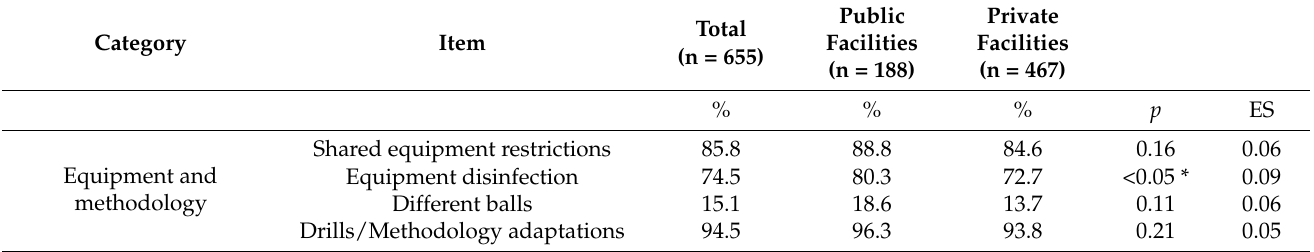
Table 4. Differences in the equipment and methodology and communication categories according type of venue.